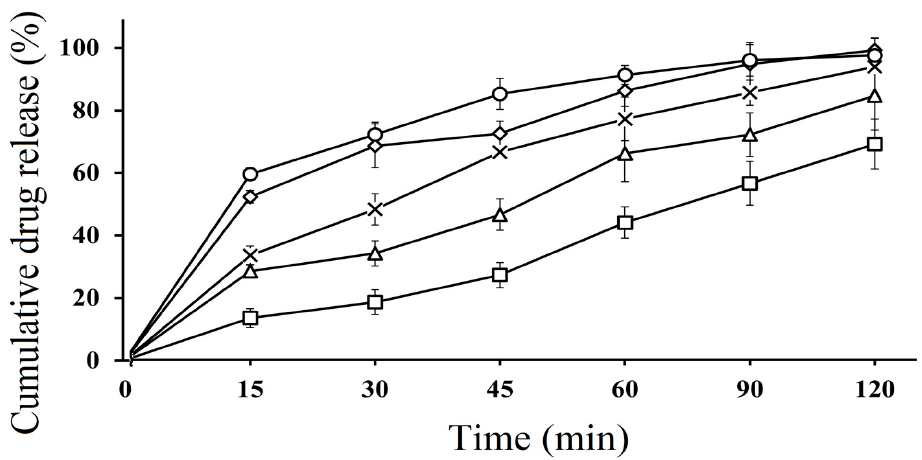
Figure 4. In vitro dissolution study of pure CFX P1 ( □ ), marketed CFX suspension F5 ( ∆ ) CFX from oily droplets F2 ( ○ ), F3 ( × ) and F4 ( ♦ ) in SIF (PBS, pH 6.8) at 37 ◦ C for 120 min. Data are presented as means ( n = 3) ± SD.